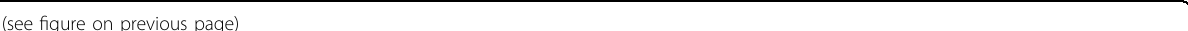
(see fi gure on previous page) Fig. 2 Cleaved Tau is observed in KI/Cre brains. a Western blot analyses of 20 μ g total proteins from 2- and 9-month-old CTO KI/Cre, CTC KI/Cre, and WT/WT hippocampal (Hc) and cortical (Cx) proteins with anti-Tau Δ D13. b Western blot analyses with anti-Tau Δ D13, anti-hTau (N-term Tau), and anti-total Tau antibodies of heat-resistant proteins (HR) from human cerebellum lysate incubated with recombinant human active Casp6p20p10 (rCasp6) ( + ) or vehicle ( − ) for 1 h or 4 h. c Tau Δ D402 fragments were immunoprecipitated from 19-month-old Tau KO, WT/WT, CTO, and CTC KI/Cre brain lysates with the anti-Tau Δ D402 antibody, and analyzed by western blotting with anti-total Tau antibody. Recombinant hTau digested with rCasp6 (Tau Δ Casp6) was used as positive control. d Western blot analyses with anti-total Tau and anti-Tau Δ D421 antibodies of HR from human cerebellum or Casp6 KO mouse brainstem lysate incubated with rCasp6 ( + ) or vehicle ( − ) for 1 h or 4 h. e, f Representative micrographs of e CTC KI/ Cre aged from 3 to 25 months (3-month-old: n = 5, 9-month-old: n = 5, 18-month-old: n = 4, 25-month-old: n = 3), and 25-month-old CTO KI/Cre ( n = 4) and WT/WT ( n = 3), or f 18-month-old CTC KI/Cre ( n = 4) hippocampus (Hc), corpus callosum (CC), and cortex (Cx) tissue sections immunostained with e anti-Tau Δ D421 or f anti- Δ Casp3 antibody. Sections from AOM-DSS-treated mouse colon and human fetal stomach were used as